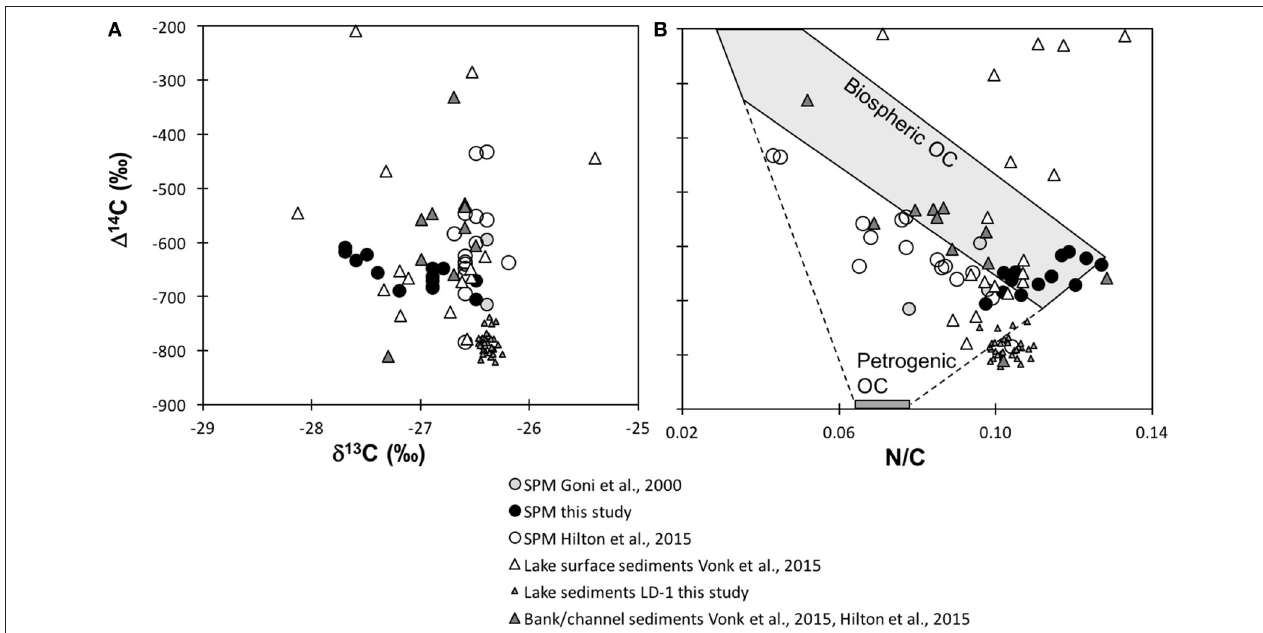
FIGURE 6 | 1 14 C values for suspended, lake, bank and channel sediments against (A) δ 13 C and (B) N/C ratios. Gray squares represent suspended sediments from the summer of 1987 (Goñi et al., 2000, 2005), black circles represent the 2008 freshet suspended sediment samples, white squares represent suspended sediments from 2009 to 2011 ( Hilton et al., 2015), white diamonds represent delta-wide lake surface sediments from 1994, 2007 to 2009 (Vonk et al., 2015 ), small gray circles represent the sediment samples from lake core LD-1, and gray triangles represent bank and channel sediments from 2009 to 2011(Hilton et al., 2015; Vonk et al., 2015). Shaded shapes in (B) represent the petrogenic and biospheric end-member values from Hilton et al.